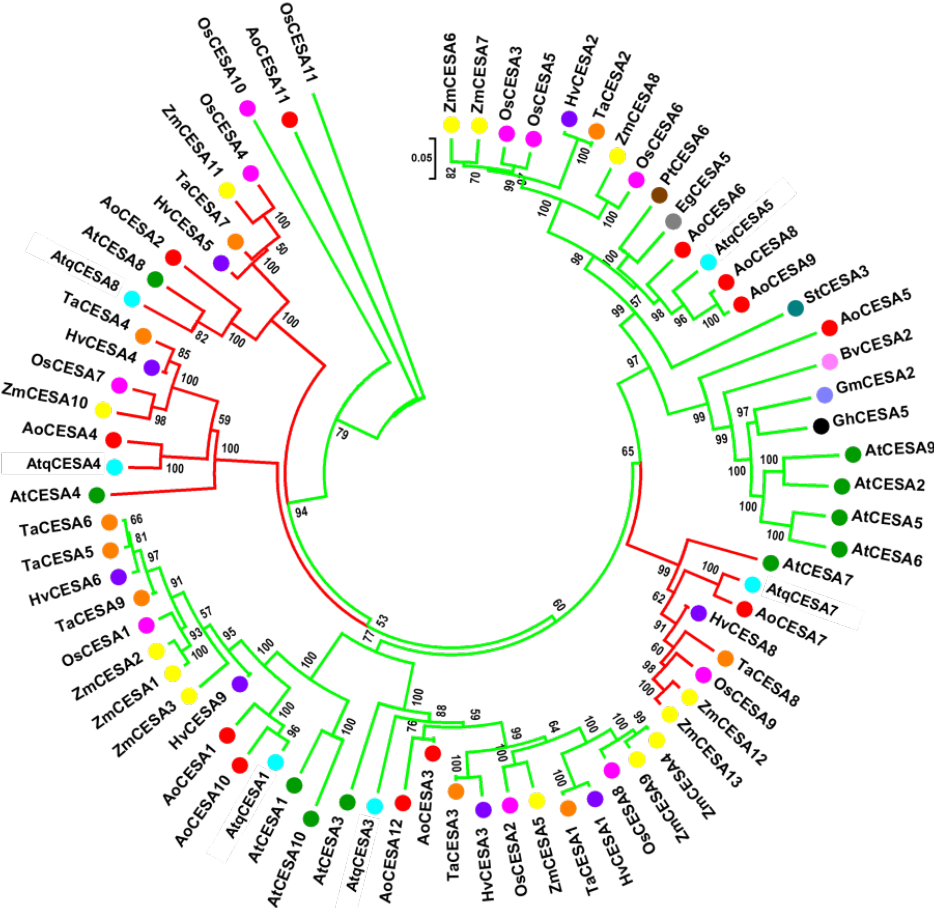
Figure 5. Unrooted phylogenetic tree of the CESAs of Agave tequilana (AtqCESA), Arabidopsis thaliana (AtCESA), Beta vulgaris (BvCESA), Eucalyptus grandis (EgCESA), Glycine max (GmCESA), Gossypium hirsutum (GhCESA), Hordeum vulgare (HvCESA), Oryza sativa (OsCESA), Populus trichocarpa (PtCESA), Solanum tuberosum (StCESA), Asparagus officinalis (AoCESA), Triticum aestivum (TaCESA), and Zea mays (ZmCESA). The phylogenetic tree was inferred using a maximum likelihood method.